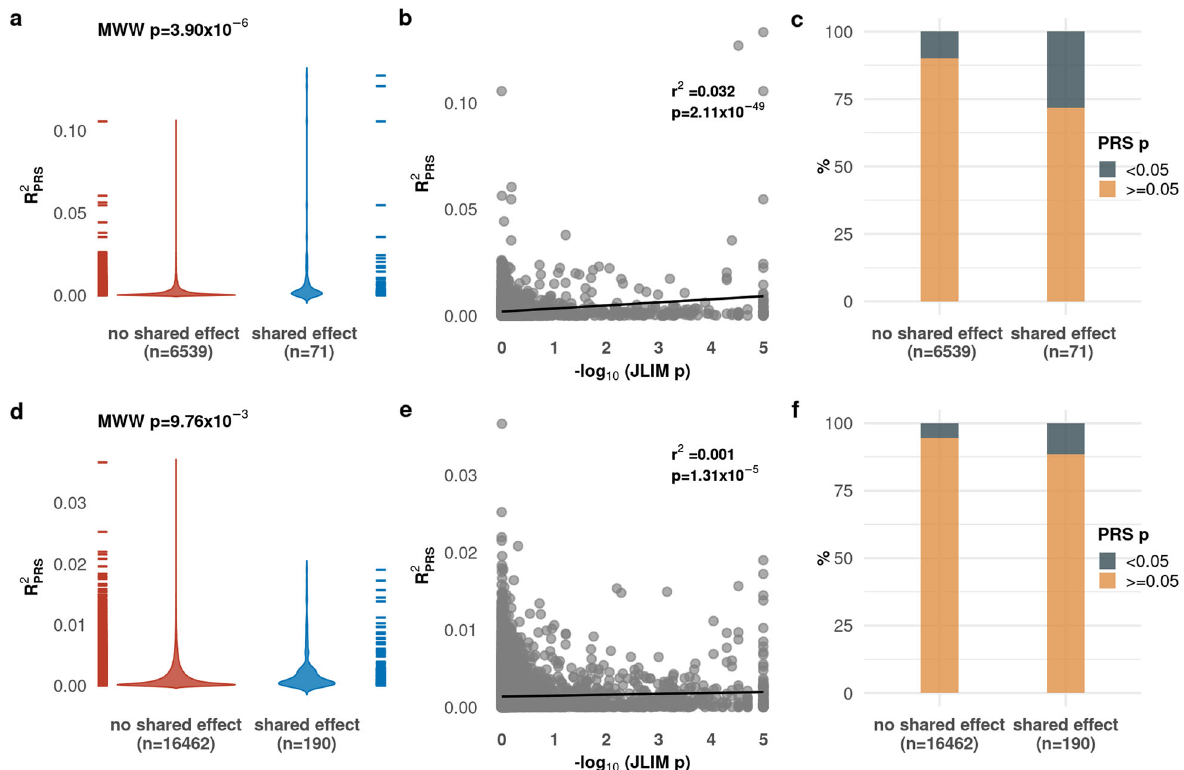
Fig. 3 The immune phenotype variance explained by gene expression polygenic risk scores (PRS) is higher for trait pairs sharing associations. We considered 16,652 gene expression/immune trait pairs in our analysis. For each, we identi fi ed all independent variants meeting a threshold of association in the gene expression trait. We used these variants to calculate PRS for each individual in the Milieu Intérieur project immune phenotype collection, and calculated the proportion of immune phenotype variance explained by these PRS (R 2 ). We found that gene expression PRS could explain signi fi cantly PRS more immune trait variance for gene expression/immune trait pairs with a shared underlying genetic effect than for those that did not share an association. We saw this effect at different thresholds for selecting PRS instruments a expression quantitative trait locus (eQTL) p < 5 × 10 − 8 ; and d eQTL p < 5 × 10 − 5 . We also found that the proportion of variance explained was correlated to the overall strength of evidence for a shared (JLIM p -value) at these two selection thresholds ( b , e ). The proportion of trait pairs with a p -value < 0.05 for the variance of the immune phenotype explained is higher in trait pairs with shared effects ( c ) as compared to trait pairs without a shared genetic effect ( f ). MWW = Mann – Whitney – Wilcoxon